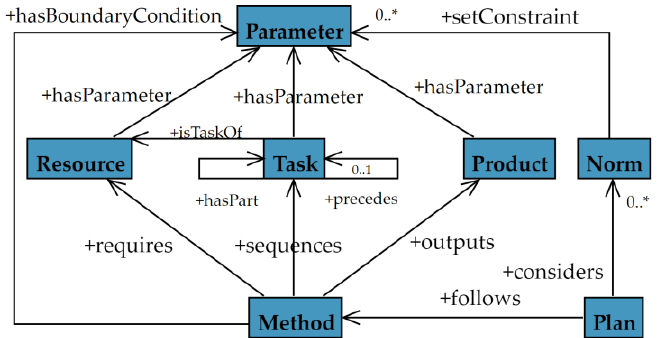
Figure 5. Conceptualization principle: planning incorporating the PPR model. Unless specified, the cardinality of the associations is set to “1..*”.